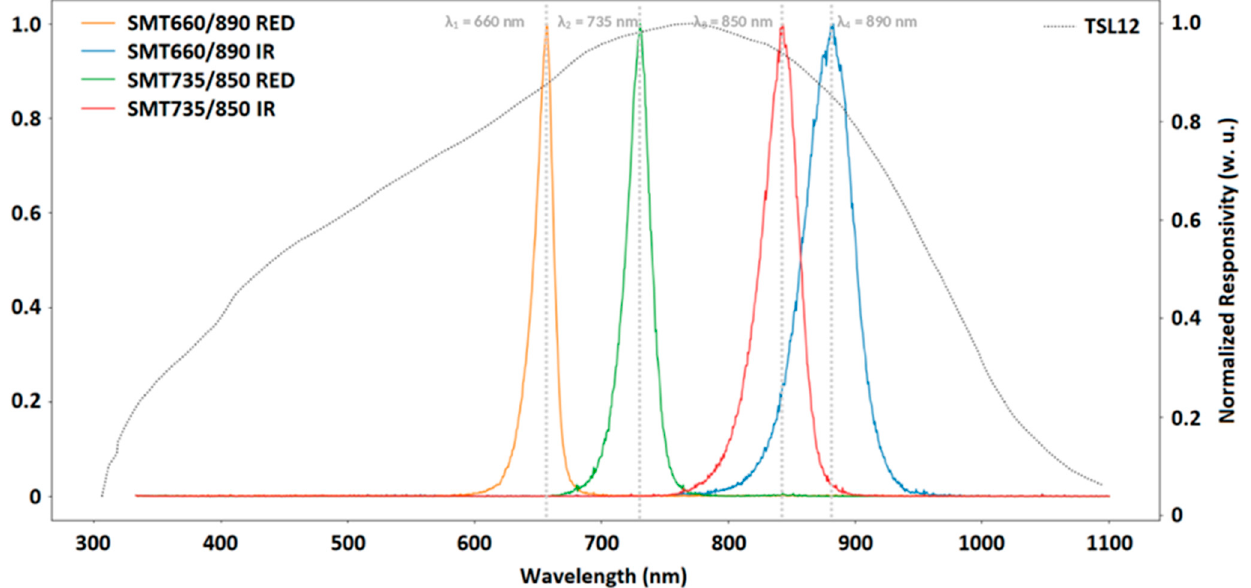
Figure 6. Spectral responses of the 4 LEDs and the photodetector (w. u. means without unit; nm: nanometer).